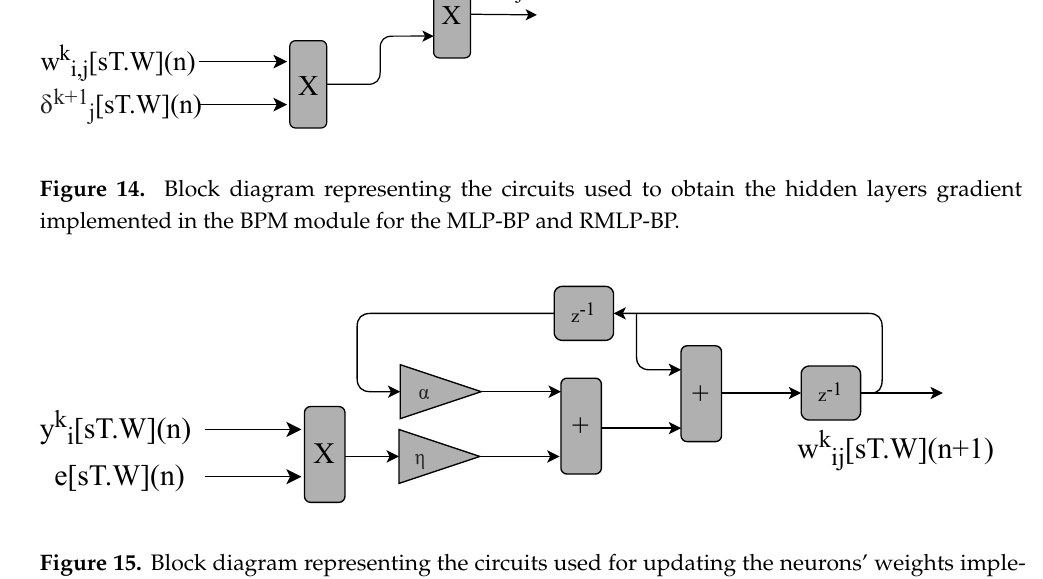
Figure 15. Block diagram representing the circuits used for updating the neurons’ weights imple- mented in the BPM module of the the MLP-BP and RMLP-BP.